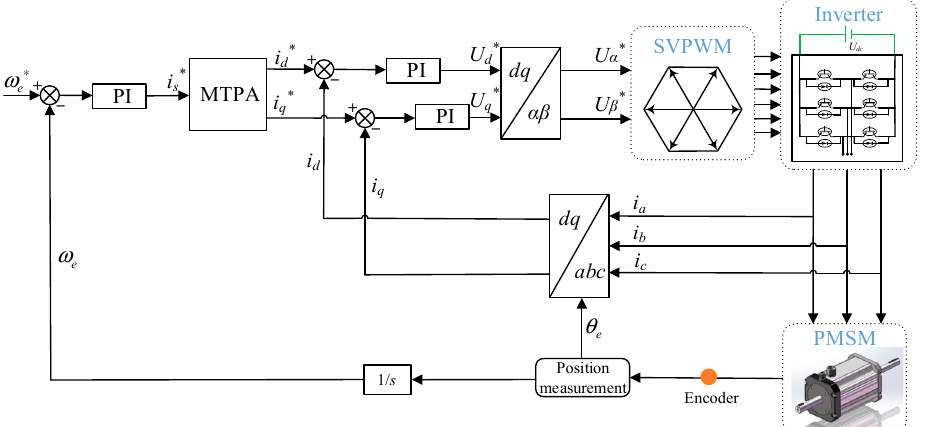
Figure 6. Block diagram of the three-phase PMSM vector control model.